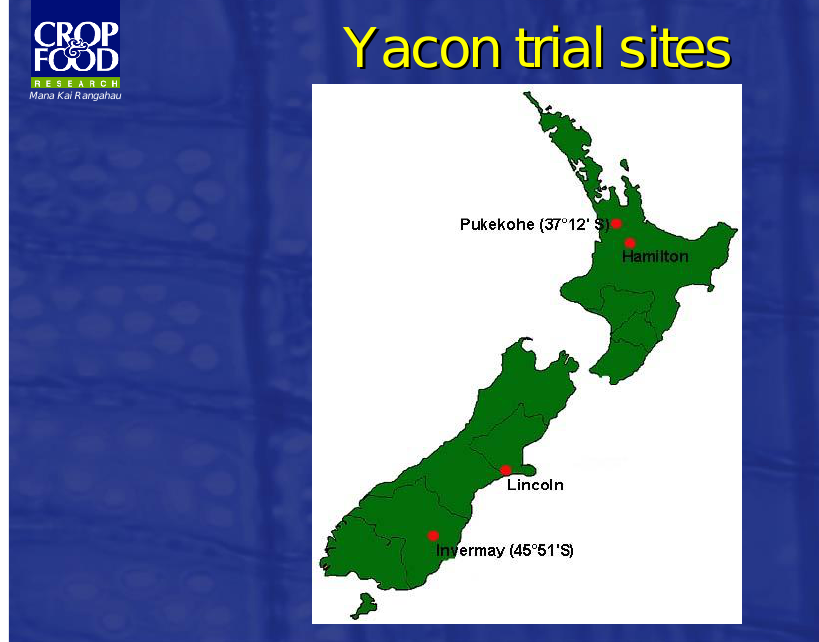
Figure 3. Yacon plants were brought to New Zealand by Crop and Food Crown Research, and trials were carried out in small plots in different regions on the basic agronomy of the crop to optimize growing and harvesting conditions.